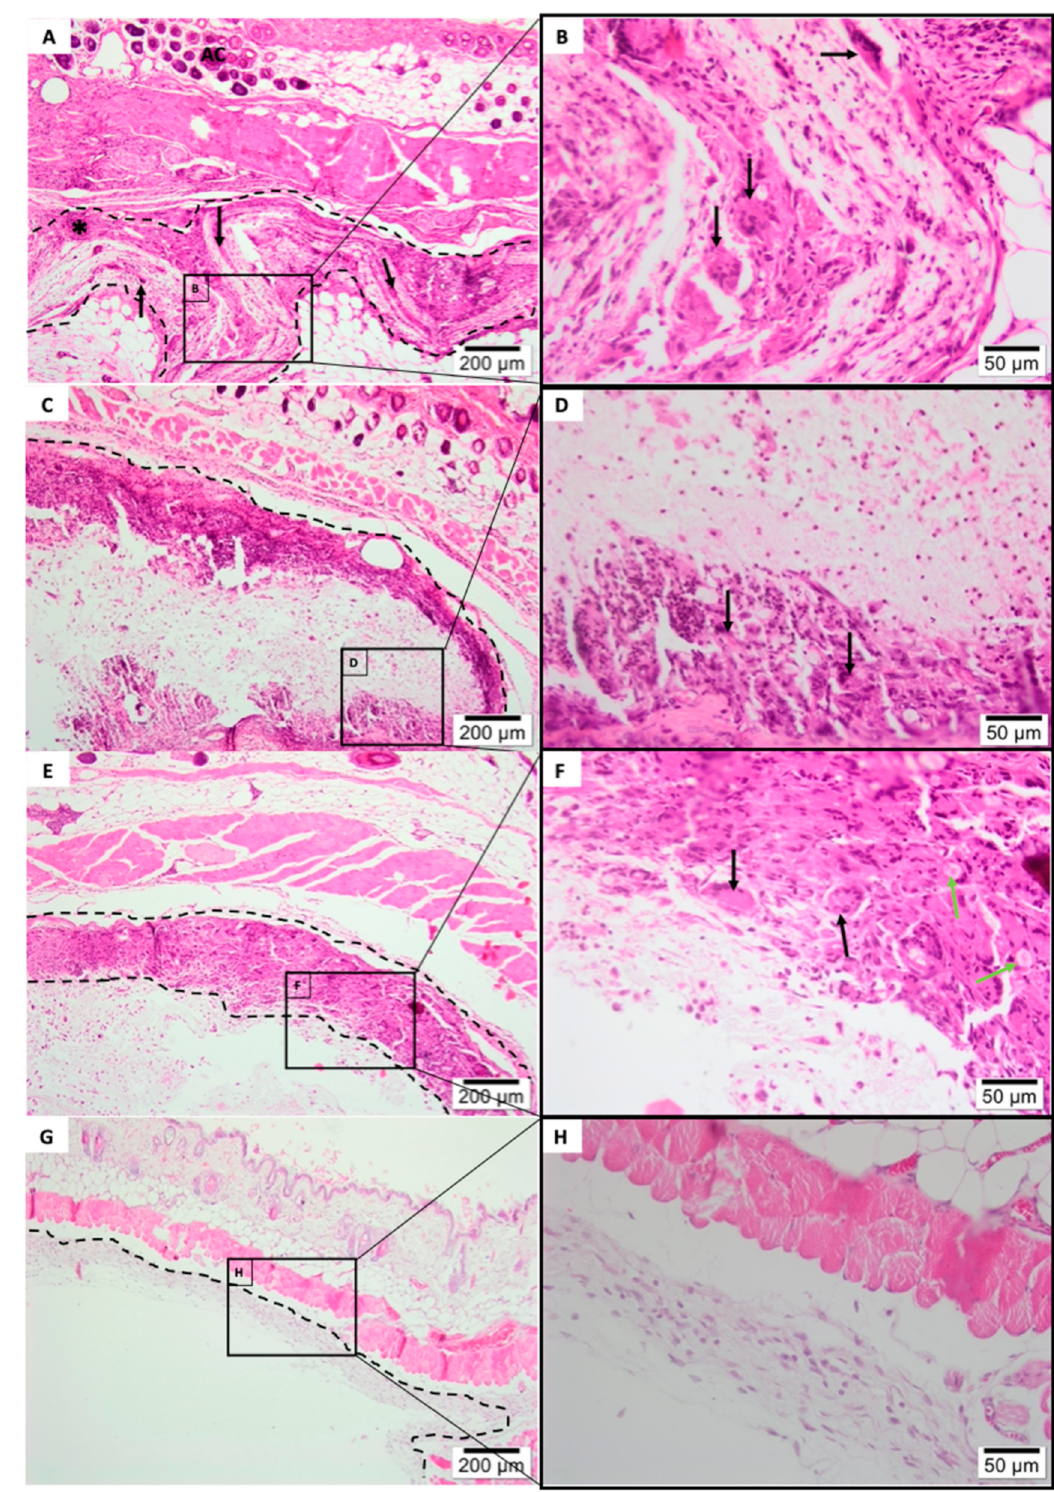
Figure 8. Histology of subcutaneous evaluation of 3-Weeks Post-implantation. Photomicrographs (optical mi- croscopy) stained with hematoxylin/eosin of the membrane implantation area (dotted line) at × 40/ × 400 magnifica- tion. ( A , B ) Tea tree Experimental Group, ( C , D ) Furanone Experimental Group, ( E , F ) Pure PLGA Experimental Group, ( G , H ) Pratix Experimental